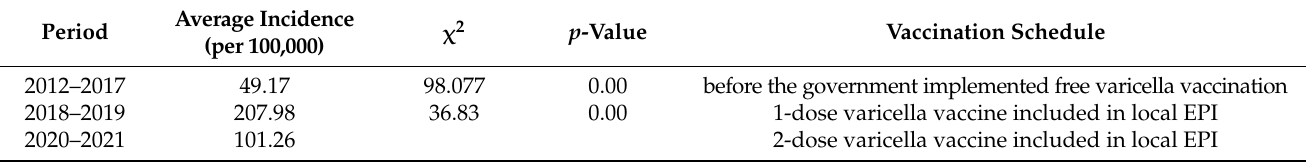
Table 1. The incidence rates and vaccination schedule of varicella in Suzhou, China, 2012–2021. Average Period